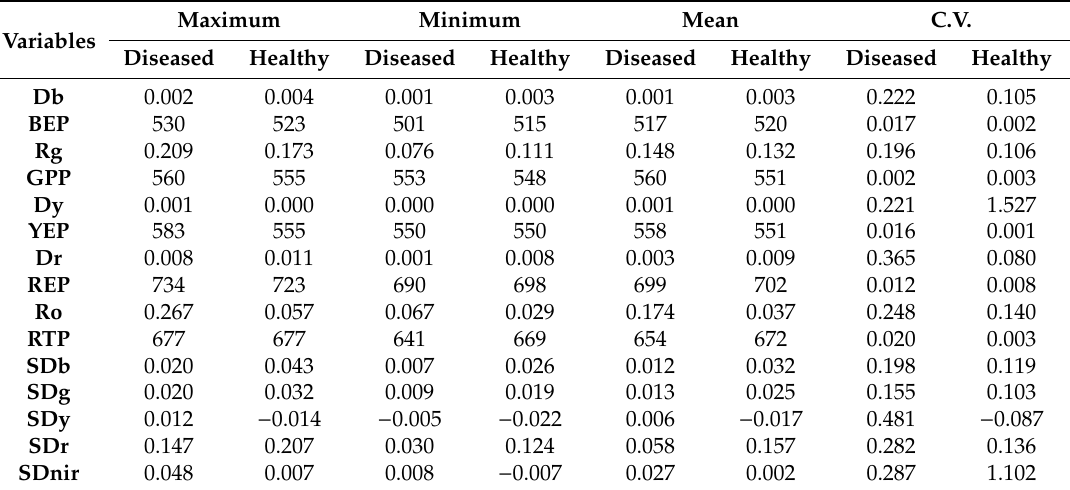
Table 1. Descriptive statistics of spectral position, amplitude and area.